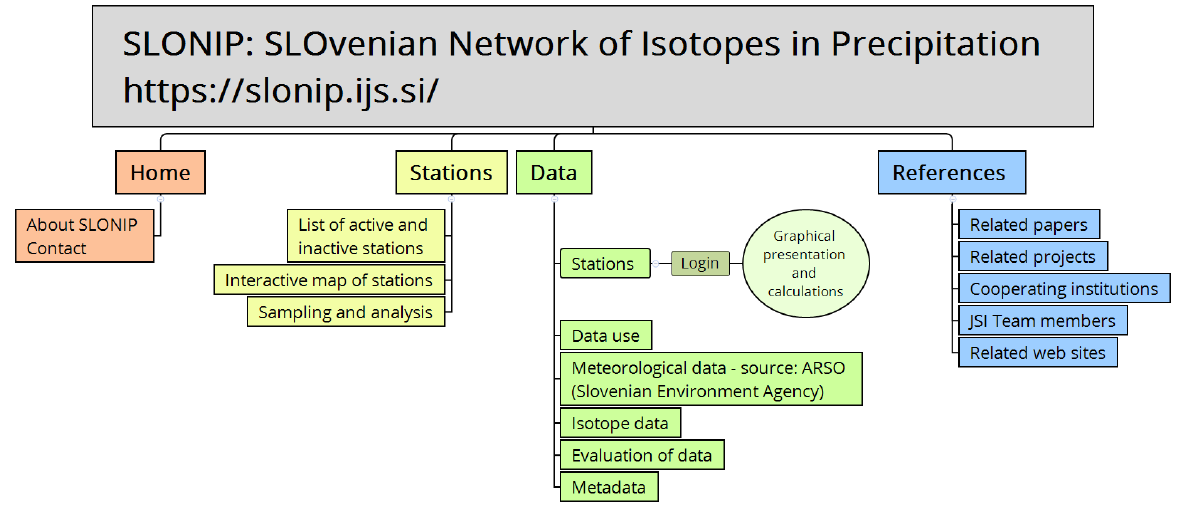
Figure 3. The schematic structure of the SLONIP website [52].